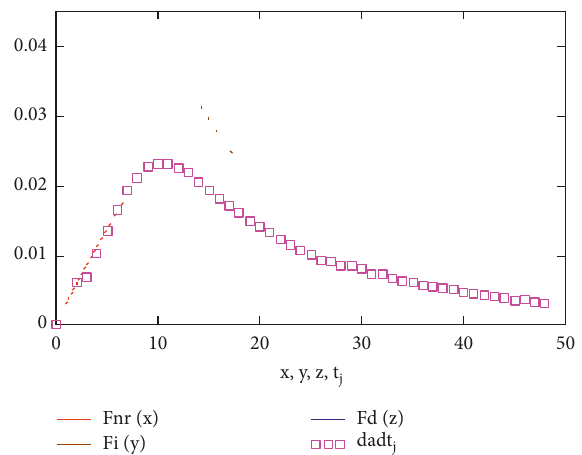
Figure 6: Hydration rate curves of sample C20SZ.